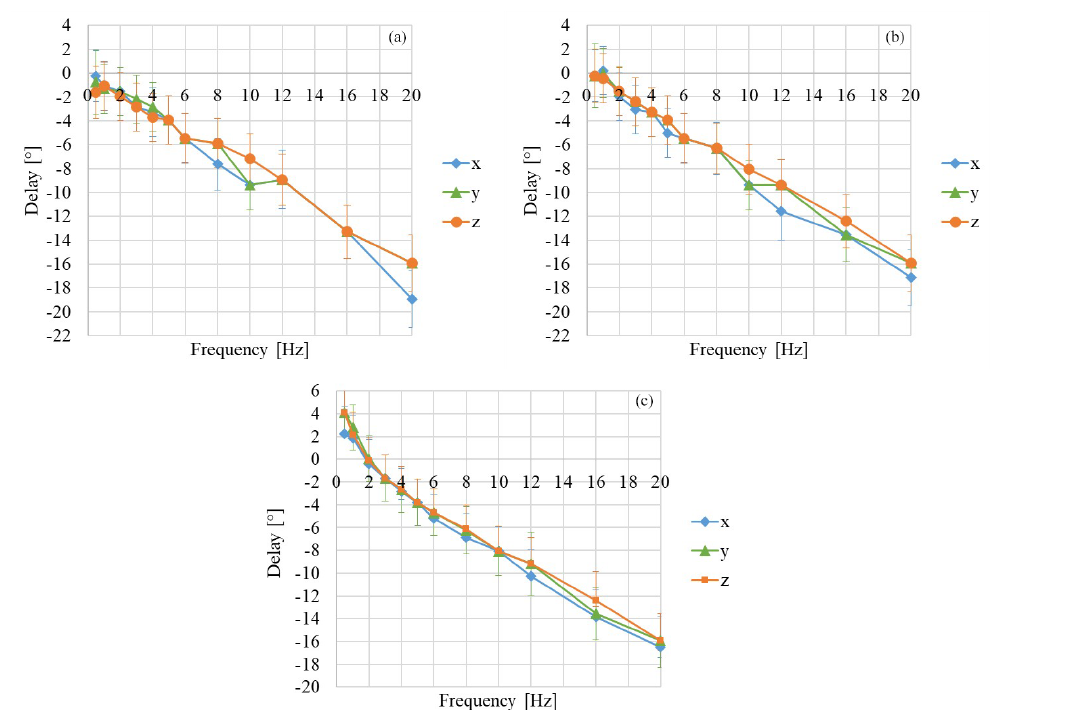
Figure 10. Experimental delay for the MEMS capacitive accelerometer: (a) analog input module 9215; (b) module 9234, DC coupled mode; (c) module 9234, AC coupled mode.